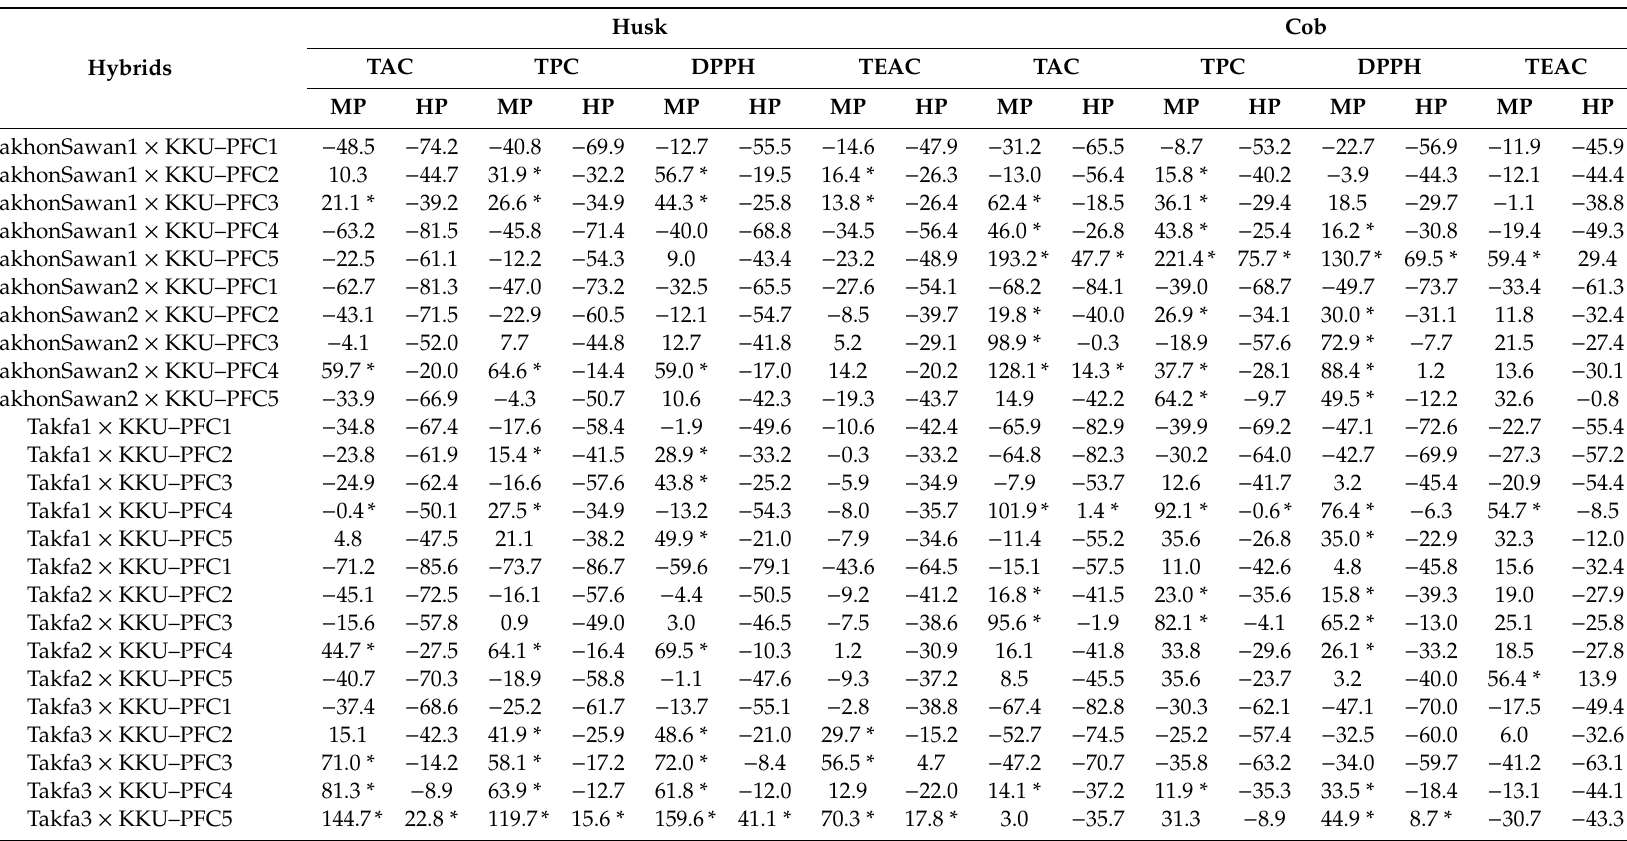
Table 11. Mid-parents heterosis (MP) and high-parents heterosis (HP) estimates for total anthocyanin content (TAC), total phenolic content (TPC), and antioxidant activity determined by DPPH and TEAC method across two